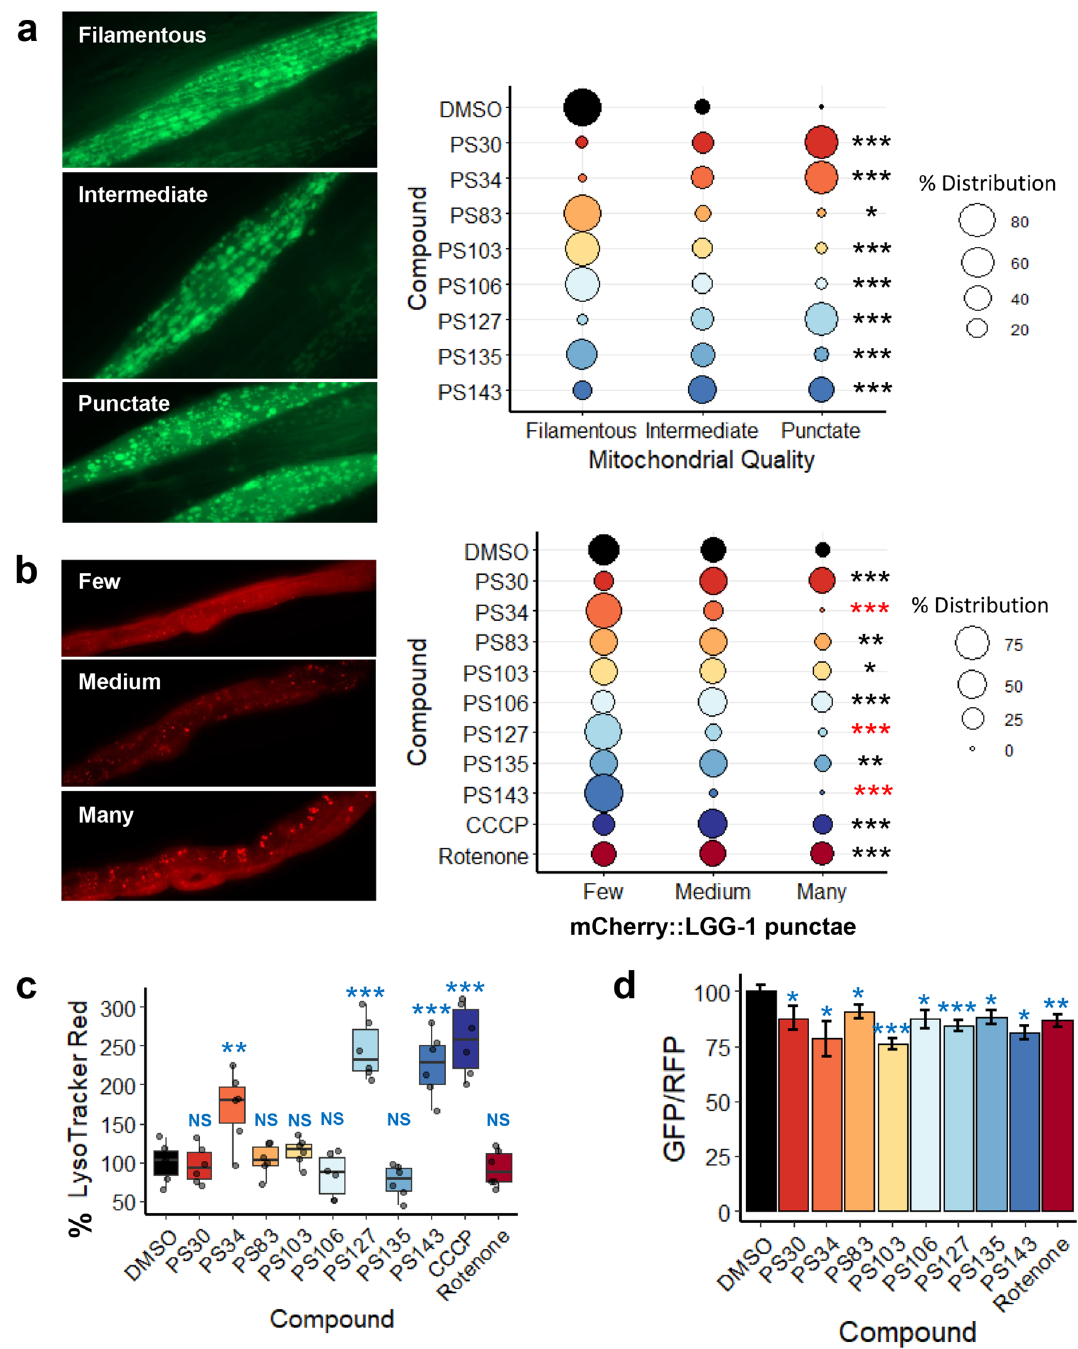
Figure 2. PS compounds induced mitochondrial fragmentation and mitophagy. ( a , b ) Fluorescent images and quantification of fluorescence of C. elegans carrying ( a ) Pmyo-3 ::GFP mt or ( b ) mCherry::LGG-1/LC3 upon 15 h of treatment with PS compounds. ( c ) Quantification of LysoTracker Red fluorescence upon 15 h of treatment with DMSO, PS compounds, CCCP, or rotenone. ( d ) GFP/RFP ratio of Rosella mt upon 15–34 h of treatment with PS compounds. For ( a , b ), percent distribution for each category was calculated and plotted, Chi-square statistic tests were performed, and representative images are shown. Three biological replicates with ~ 30 worms/ replicate were analyzed. For ( c ), at least four biological replicates with ~ 400 worms/replicate were analyzed. For ( d ), at least three biological replicates with ~ 20 worms/replicate were analyzed. Representative images for ( d ) were shown in Fig. S2. For ( c , d ), p -values were determined from one-way ANOVA, followed by Dunnett’s test. All fold changes were normalized to DMSO control (at 100%), thus increased fluorescence (as compared to DMSO) will cause quantification values to be over 100%. NS not significant, * p < 0.05, ** p < 0.01, *** p < 0.001. In ( b ), black star indicates significance of increase while red indicates significance of decrease of mCherry::LGG-1 punctae